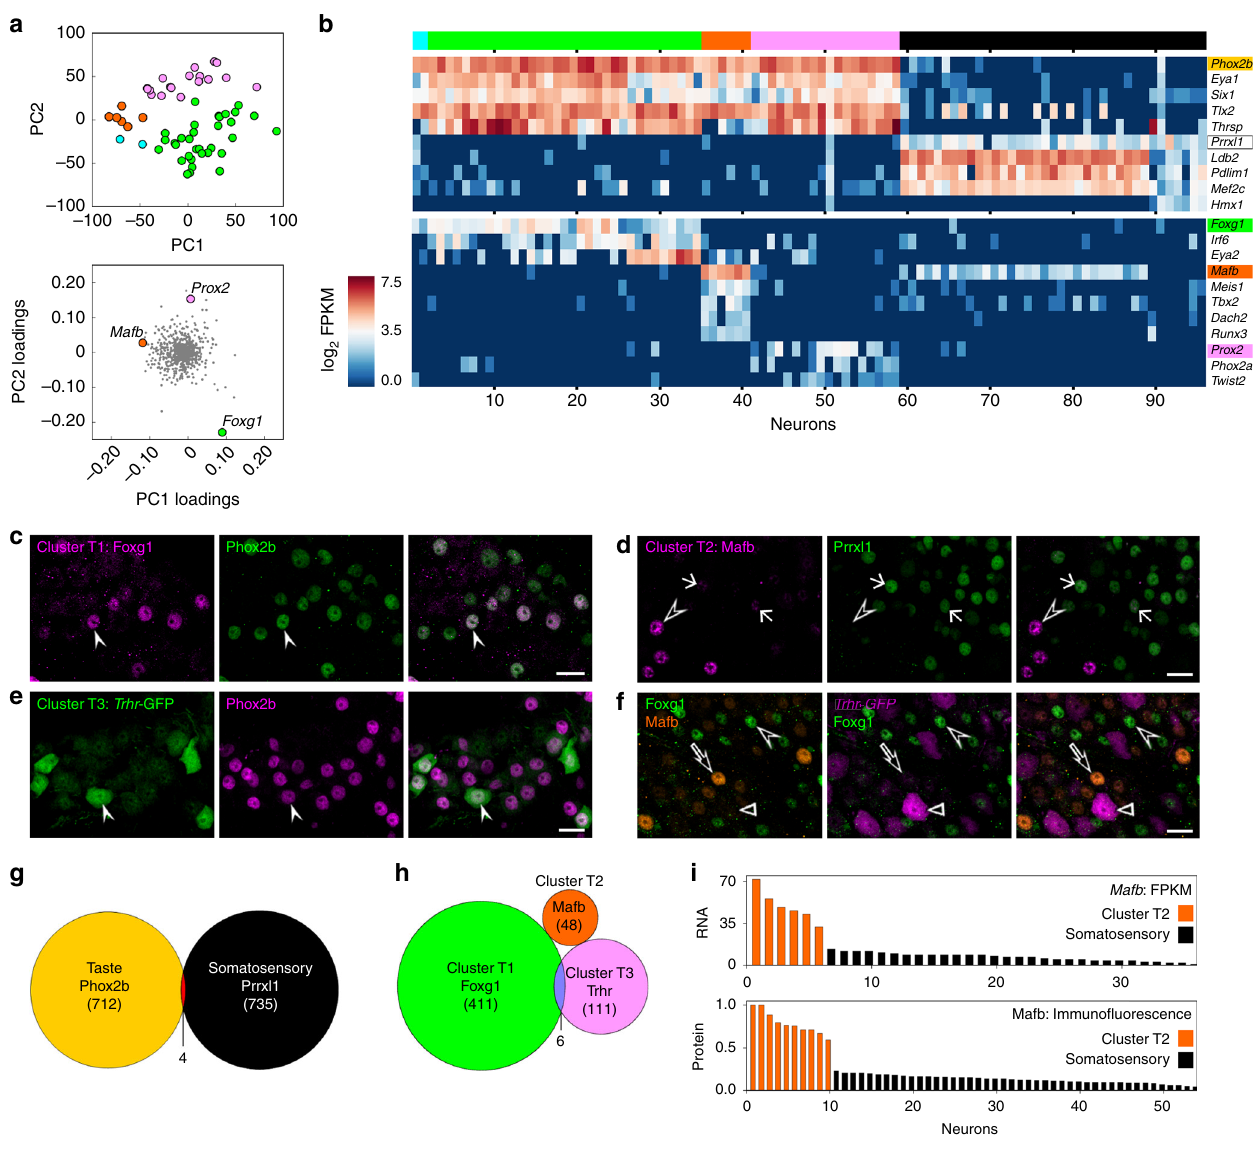
Fig. 5 Transcription factors (TFs) de fi ne non-overlapping subclusters of gustatory neurons. a . PCA of 59 gustatory geniculate ganglion neurons, colored as in Fig. 4a, based on expression of 976 TFs ( upper plot). Principal component loadings ( bottom plot) reveal divergent positions occupied by sub-cluster- selective TFs. b . Expression levels (log 2 FPKM) of TFs in all 96 neurons. Gustatory neuron sub-clusters, T1, T2, T3, are green, orange and pink respectively; somatosensory neurons are black. The upper heat map shows expression of 5 gustatory- and 5 somatosensory-selective TFs. The lower heat map shows expression levels for 11 gustatory sub-cluster-selective TFs. c . Immunostaining of a geniculate ganglion for Foxg1 (proposed T1 marker) and Phox2b (gustatory marker). All Foxg1+ neurons counted (243 neurons; 3 mice) were also Phox2b-immunoreactive fi lled arrowhead; Foxg1+neurons accounted for 59% of Phox2b+ neurons. d . Immunostaining of a geniculate ganglion with anti-Mafb (proposed T2 marker) and anti-Prrxl1 (somatosensory marker). Mafb-bright nuclei (un fi lled triangle) do not overlap with Prrxl1-immunoreactivity (0 of 29 nuclei; 3 mice). However, faint staining for Mafb was also detected in many Prrxl1-positive (i.e. somatosensory) nuclei. e . Immunostaining of a ganglion from a Trhr-GFP mouse (proposed T3 marker) with anti-GFP and anti-Phox2b. 80 of 81 GFP+ neurons (3 mice) contained a Phox2b-immunoreactive nucleus. f . Triple immunostaining for Foxg1, Mafb, and GFP on geniculate ganglia from a Trhr -GFP mouse reveals a mutually exclusive pattern of expression of the three markers. g . Venn diagram of Phox2b, Prrxl1, and NeuN expression based on triple immuno fl uorescence (expanding on Fig. 3b). Of 1452 NeuN+ nuclei examined (from 3 mice), only 4 were immunoreactive for both Phox2b and Prrxl1 and 1 stained for neither. h . Venn diagram for taste sub-clusters, based on triple immuno fl uorescence for Mafb, Foxg1 and GFP on geniculate ganglia from Trhr-GFP mice. 570 of 576 cells (3 mice) displayed a non-overlapping pattern of the three markers. i . Bar graphs compare FPKM values for Mafb (T2 neurons) across all sequenced neurons and quanti fi ed fl uorescence after immunostaining for Mafb. Co-staining with Prrxl1 (as in d ) was used to assign neuronal identity to either taste cluster T2 or the somatosensory cluster. All scale bars , 20 μ